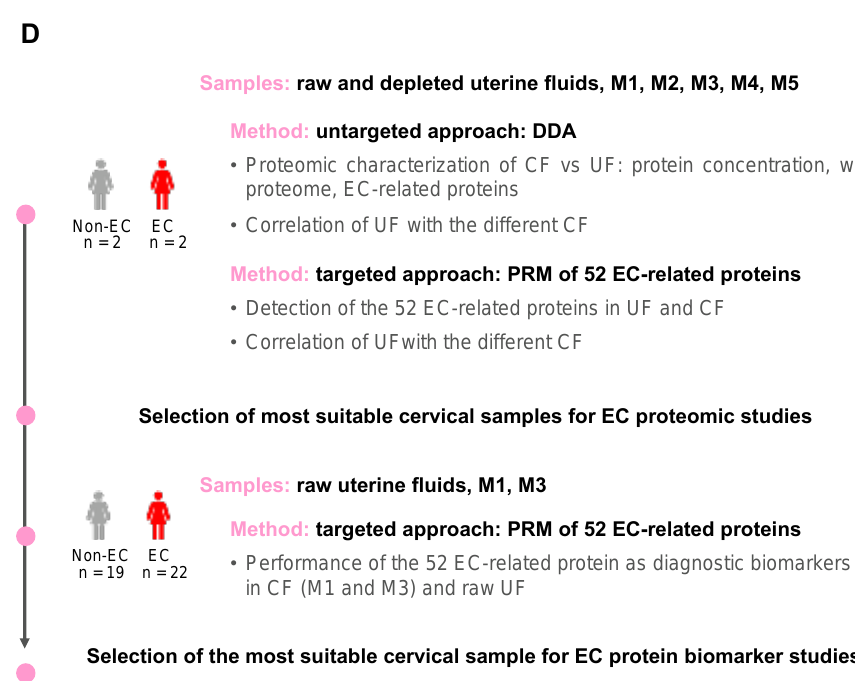
Figure 1. Clinical samples evaluated and general workflow of the study. ( A ): Medical tools used to collect the samples: brushes (for cervical samples M1–M5) and Cornier Pipelle (for pipelle biopsies, PB). ( B ): Collection site of the different samples. ( C ): Description of the methodology (tools, volume,